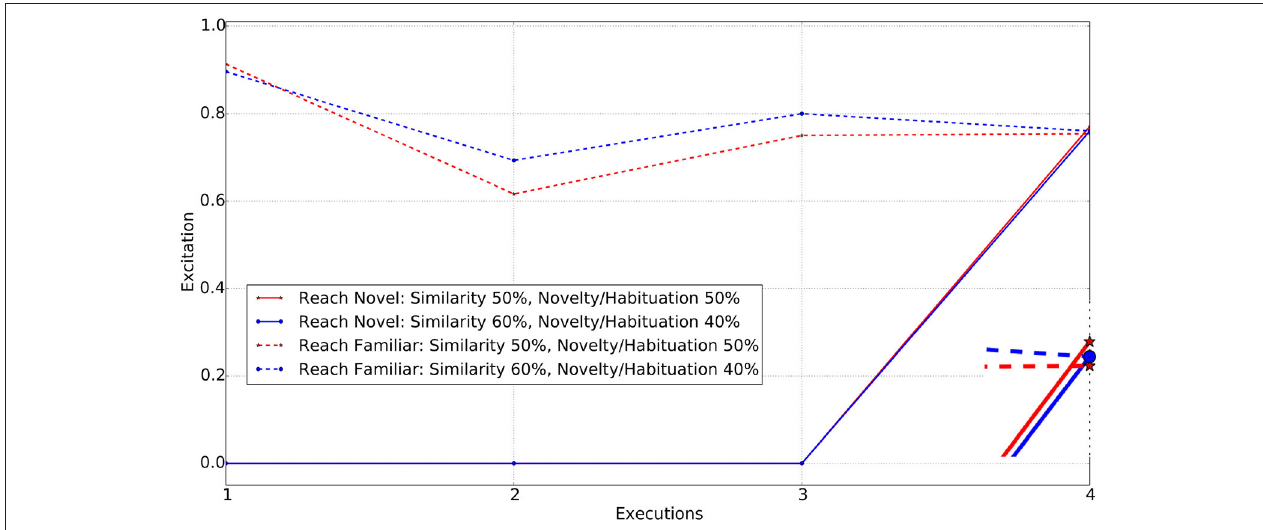
FIGURE 5 | Reach actions for Familiar vs. Novel (identical in color and shape) object. Enclosed Figure shows the excitations at the 4 th